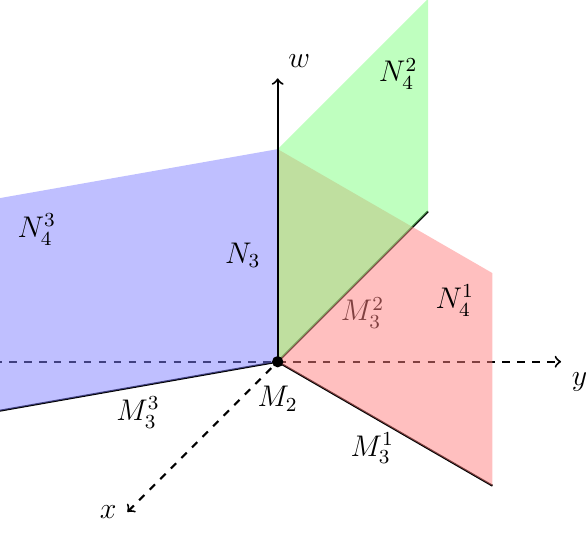
Figure 5: The geometry of the extensions of the interfaces and the interface junction. The two transverse directions are not shown in the figure. w is the coordinate for the